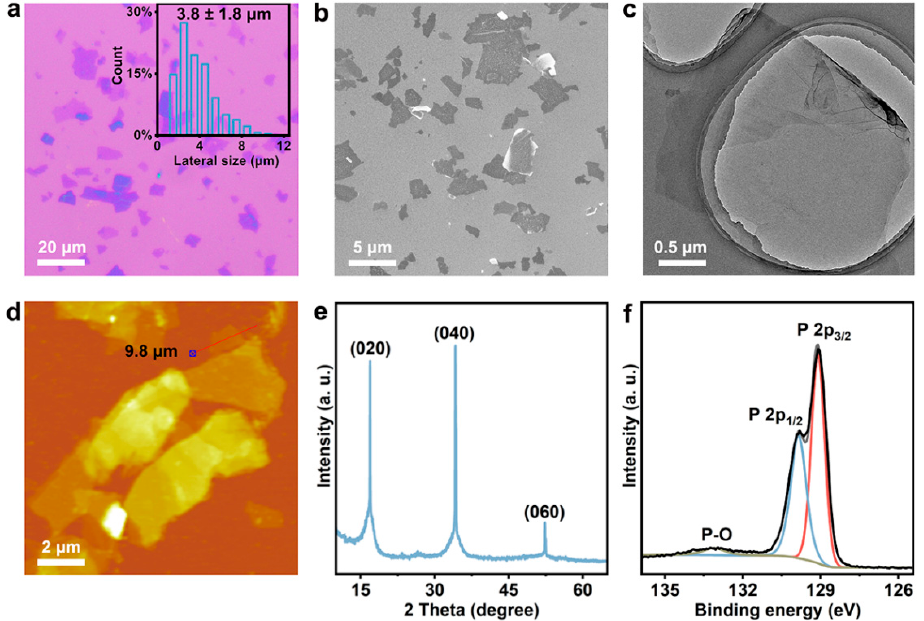
Figure 1. Characterization of BP microplates. ( a ) Photomicrograph of the BP microplates with an insert of lateral diameter statistics. ( b ) SEM image of the BP microplates. ( c ) TEM image of the BP microplate. ( d ) AFM image of the BP microplates with a height profile. ( e ) XRD pattern of the BP microplates containing the characteristic crystal planes of BP. ( f ) P2p XPS spectrum of the BP microplate.